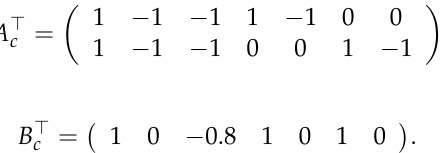
/ ∆ and R e ,2 / ∆ ( right ) at the end of each rebalancing t t